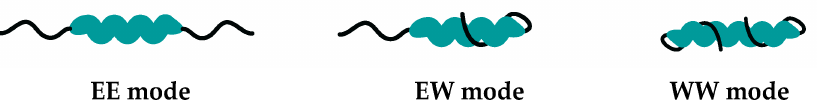
Figure 3. H. suis bacterium corresponding to either an extended (E) or a wrapped (W) configuration of the flagellar bundle. The EE mode corresponds to both bundles extended, EW to one extended and the other wrapped, and WW to both wrapped. Adapted from Constantino [57] under a Creative Commons Attribution 4.0 International License.